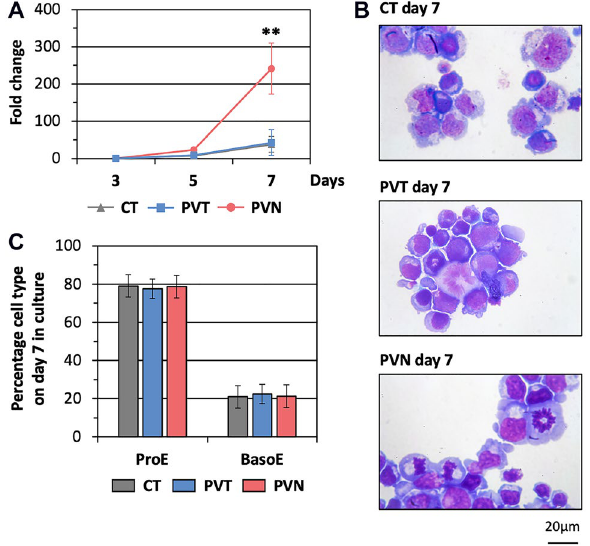
Figure 1. Erythroblasts from PV patients exhibit increased proliferative capacity. Erythroblasts were differentiated from peripheral CD34 + cells of newly-diagnosed PV patients (PVN), PV patients who received cytoreductive therapy until their haematocrit was in the normal range (PVT), and healthy subjects as a control group (CT). ( A ) Fold-expansion from day 3 to 7 in culture, mean ± SD of three independent cultures. ** p -value < 0.01, ANOVA. ( B ) Morphology of day 7 cultured cells stained with Leishman’s reagent, representative images of three independent cultures, magnification 100 ×. ( C ) Proportion of cells at